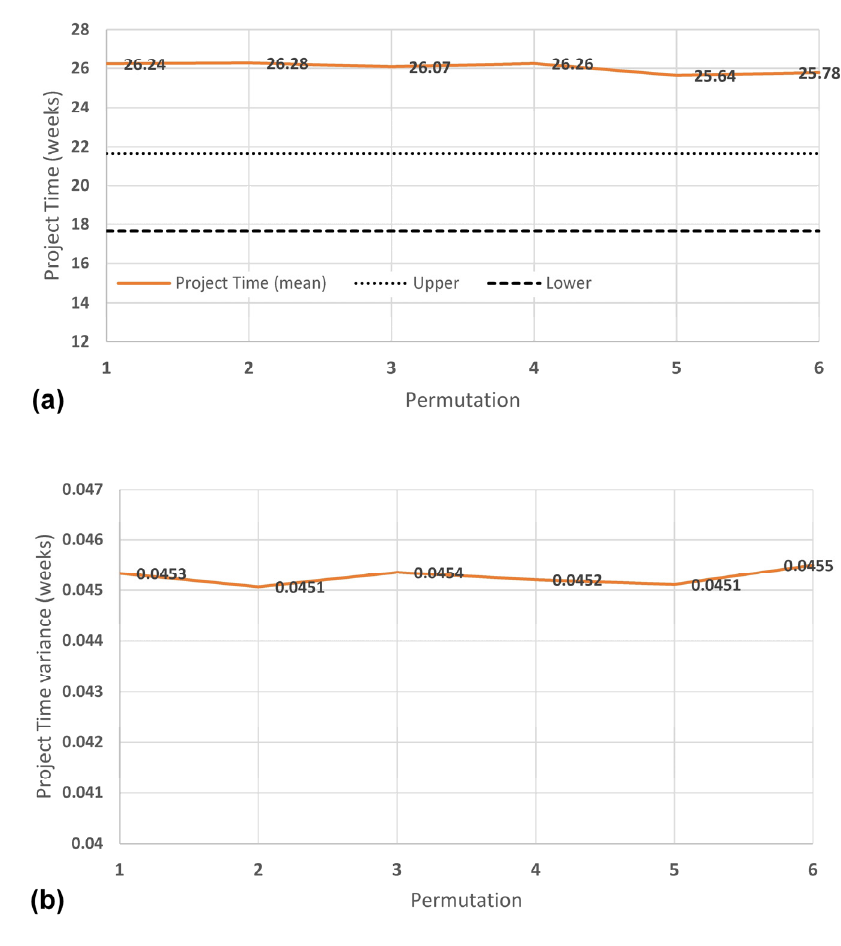
Figure 8. Project time estimates for each permutation and effective risk evaluated with RPI component only. ( a ) Project time estimates for each permutation. ( b ) Variance estimates for each permutation.